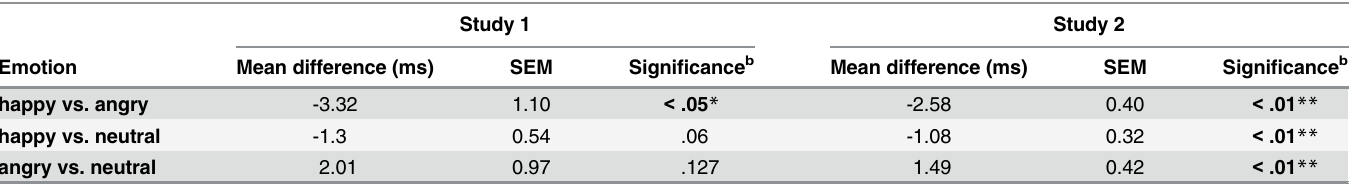
Table 7. Mean latency difference (ms) between facial expressions and standard error of the mean (SEM);